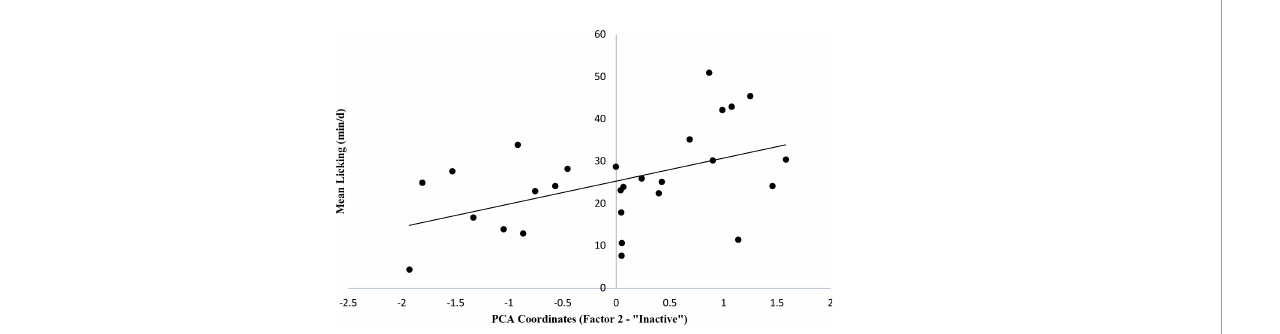
FIGURE 3 Average time spent licking (non-nutritive oral behavior in the home pen) of individually housed Holstein x Angus crossbred calves (n = 29) during the 76- d experimental period, plotted against Factor 2 ( “ Inactive ” ) from the principal component analysis of the standardized personality tests. Each black dot represents a calf, and the linear regression trendline is presented ( P <